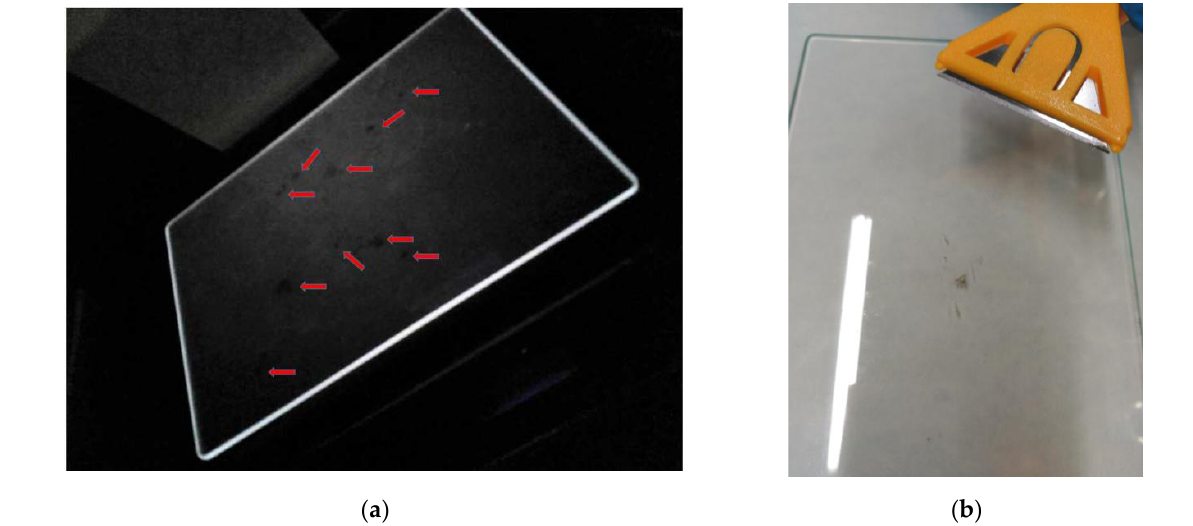
Figure 4. At the laboratory, the removed glass plate from the venom collector device after Vespa velutina electric stimulation ( a ) under UV light, showing venom-dried spots (red arrows); ( b ) scrape of the venom.